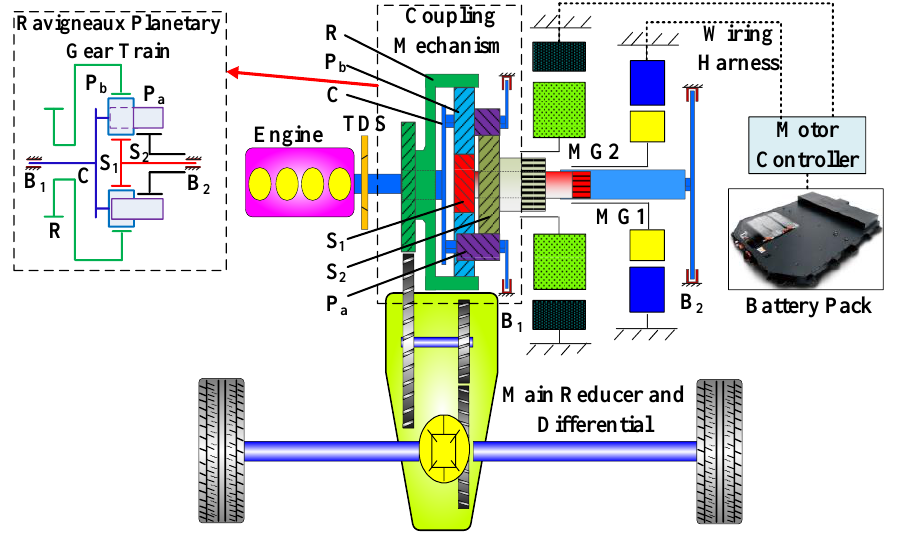
Figure 1. Structure diagram of the compound PS-PHEV.